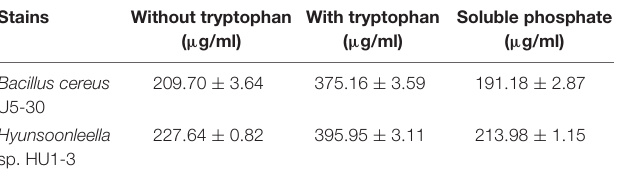
TABLE 3 | The production of IAA and the solubilization capacity of phosphate in the strain. Stains Without tryptophan